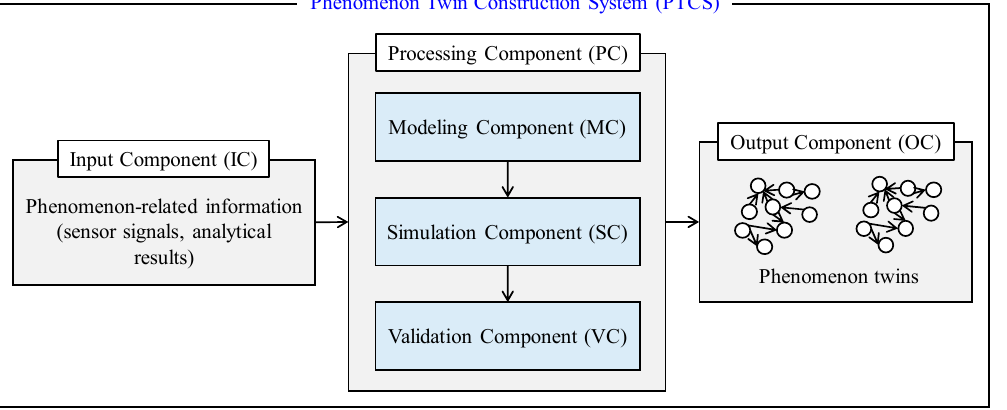
Figure 2. Proposed architecture of Phenomenon Twin Construction System (PTCS).